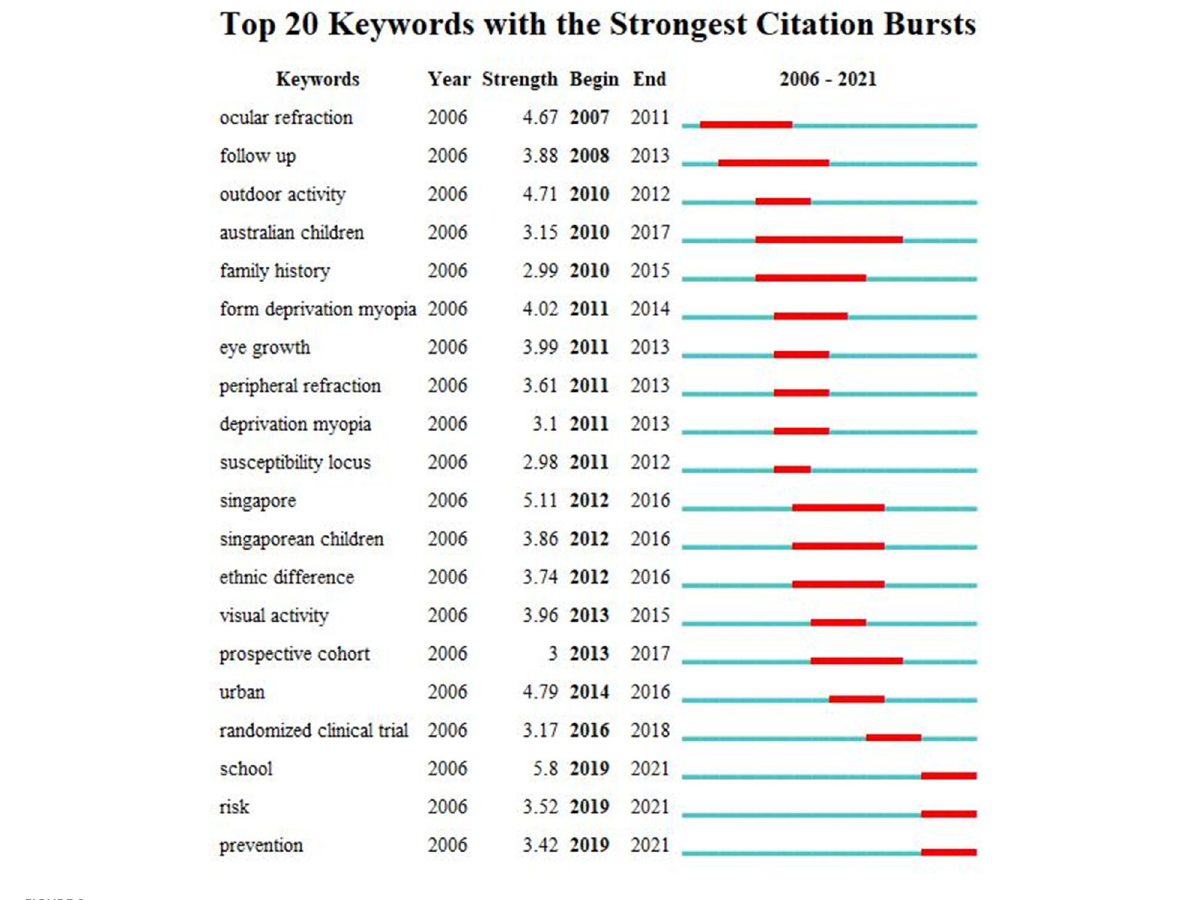
FIGURE8 Top 20 keywords with the strongest citation